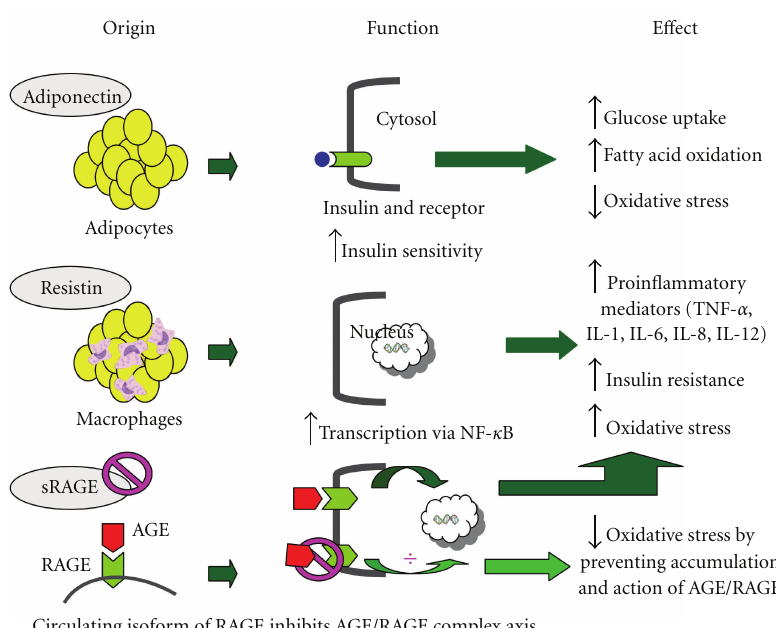
Figure 1: Adiponectin, resistin, and sRAGE as inflammatory/metabolic mediators in human